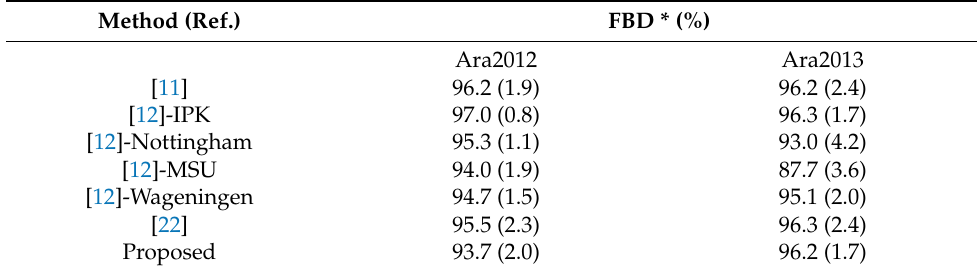
Table 4. Comparison of leaf detection performance. Method (Ref.)